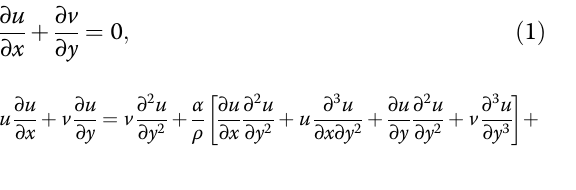
Table 2 Comparison of the results for the Nusselt number ( – θ ′ (0)) when Ln = Pr = 10 and Nd = L e = Ld = α = λ = 0, Bi = 1 , M = 1.5 , Nc = 0.1 , R = 1 , θ w = 1 Nt − θ ′ (0) Nb = 0.1 Nb =